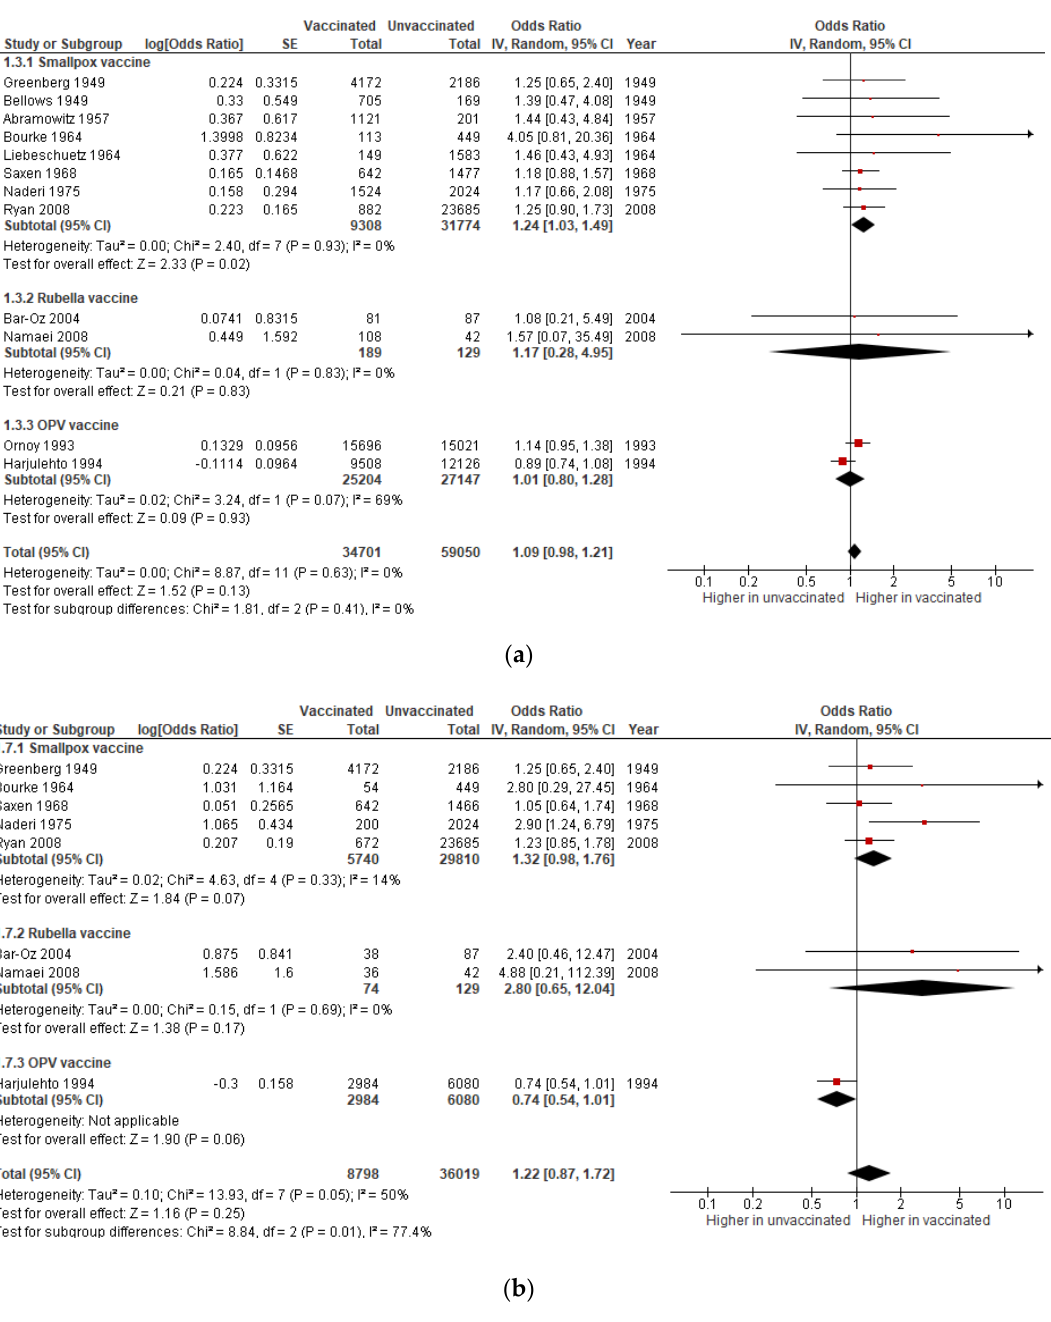
Figure 4. Meta-analysis of the association of maternal immunization with congenital anomalies.